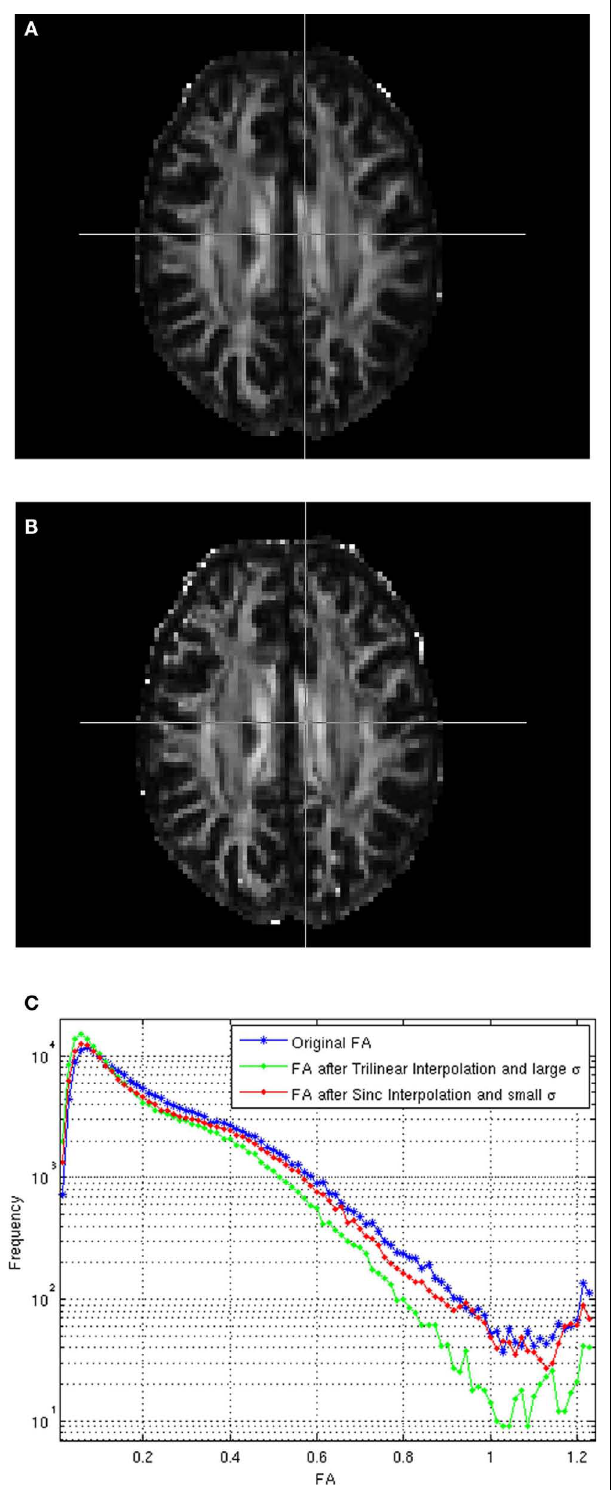
FIGUREA1 | (A) FA of the registered image using trilinear interpolation and large σ . (B) FA registered using sinc interpolation and small σ , (C) Histograms of the